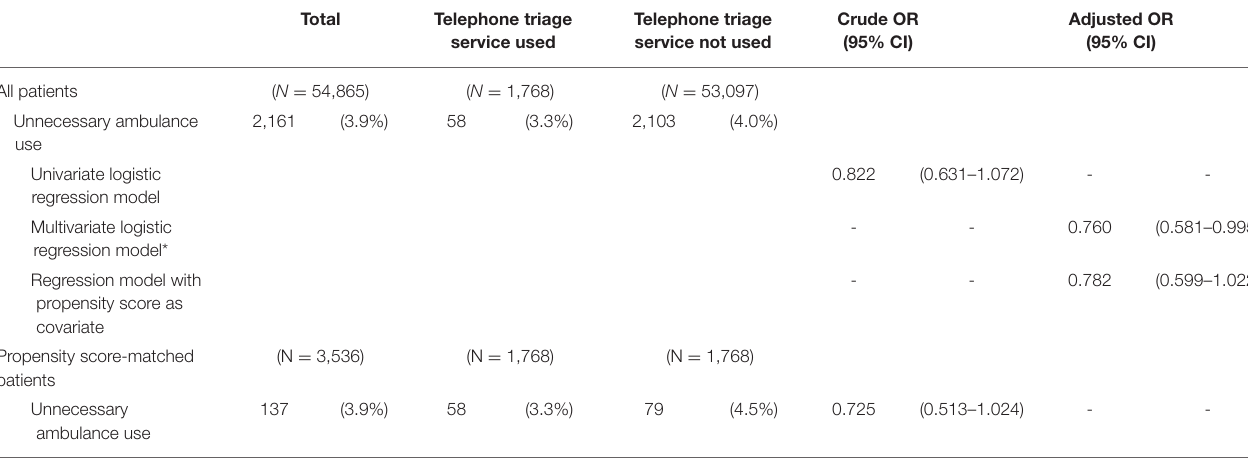
TABLE 3 | Unnecessary ambulance use with or without telephone triage service among children.